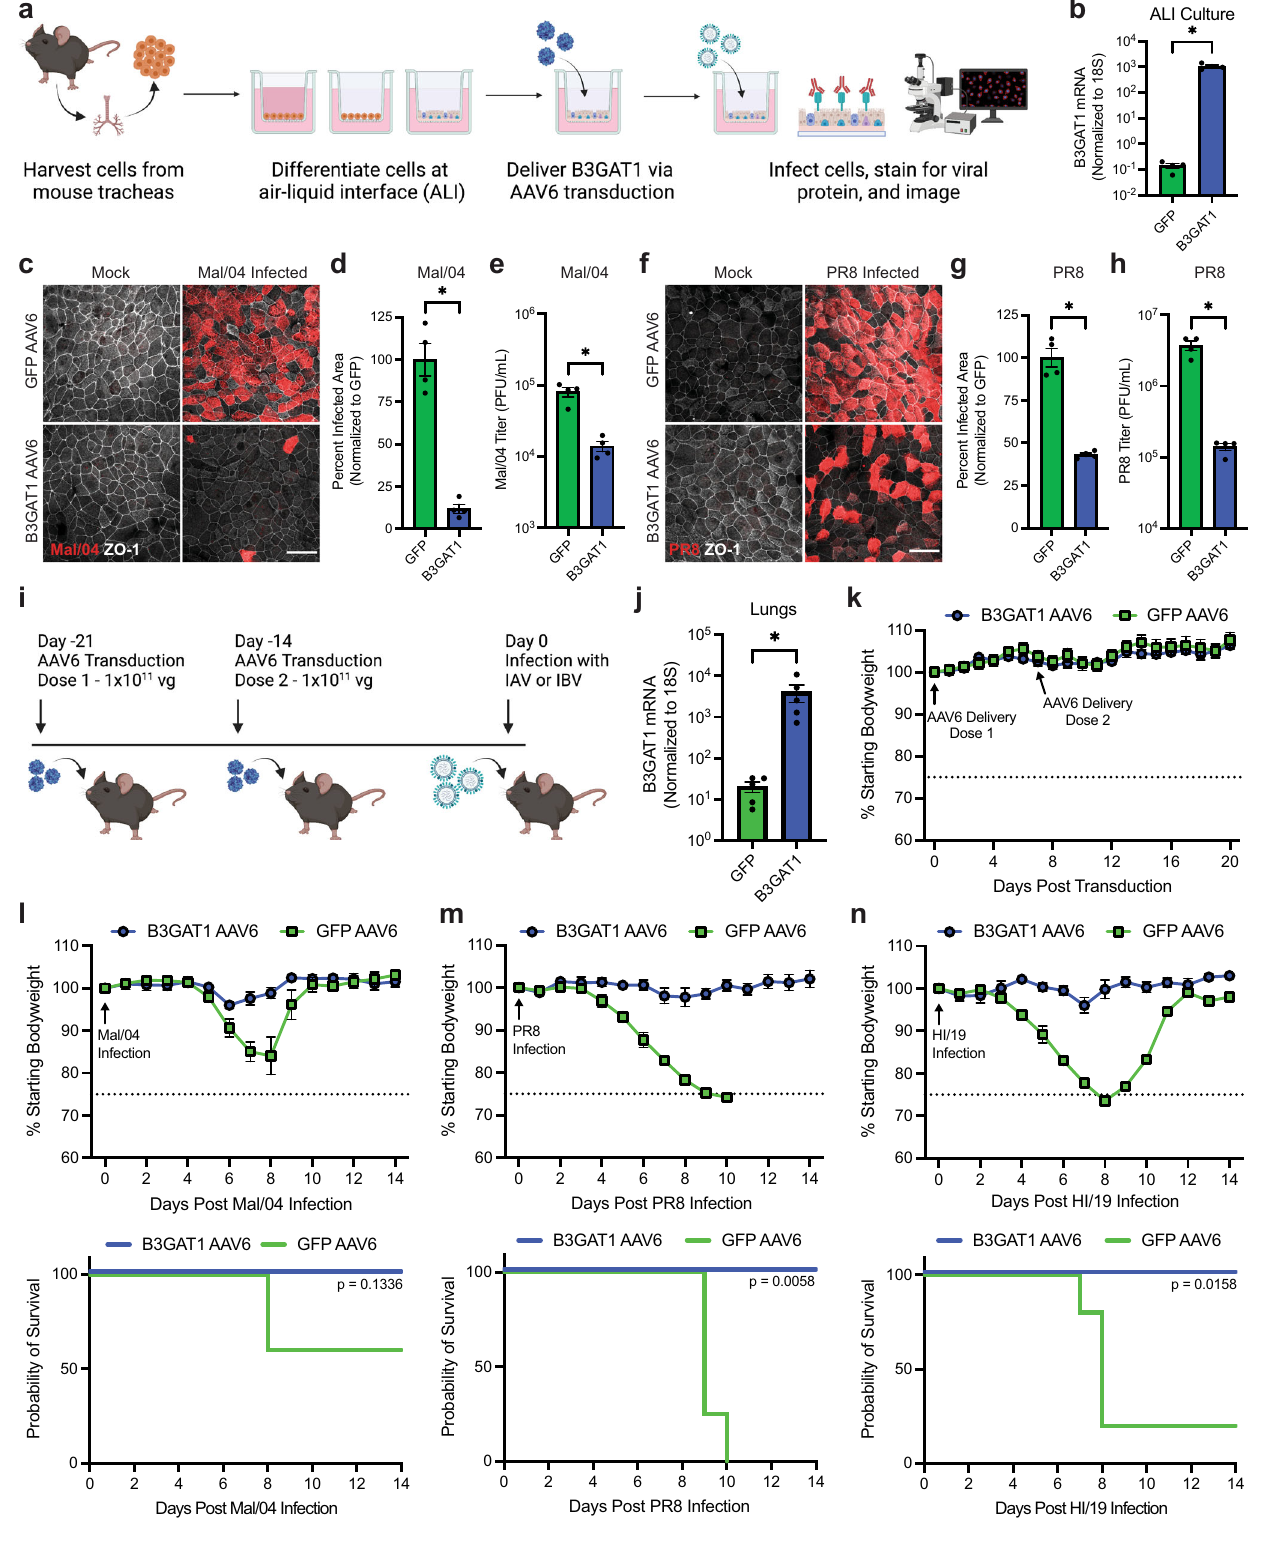
Cell lines A549, HEK 293T, MDCK, and NL20 cell lines were obtained from the ATCC and cultured at 37°C with 5% CO 2 . A549 and HEK 293T cells were grown in Dulbecco ’ s Modi fi ed Eagle Medium (DMEM) with 5 – 10% FBS, GlutaMAX, and penicillin/streptomycin. MDCK cells were grown in Minimal Essential Medium (MEM) with 5% FBS, GlutaMAX,